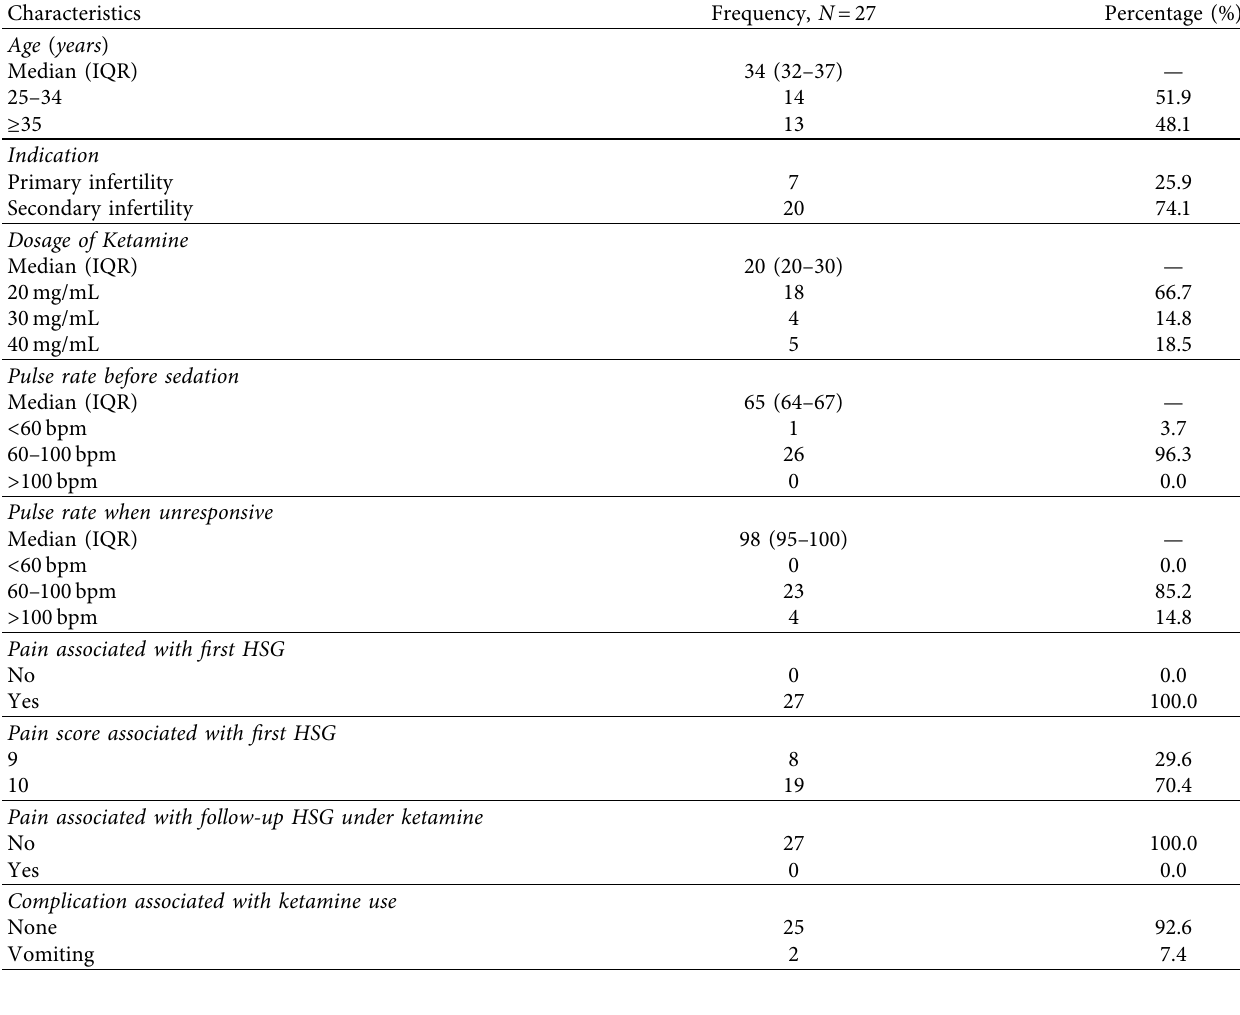
Table 1: Characteristics of patients undergoing ketamine sedation for HSG.